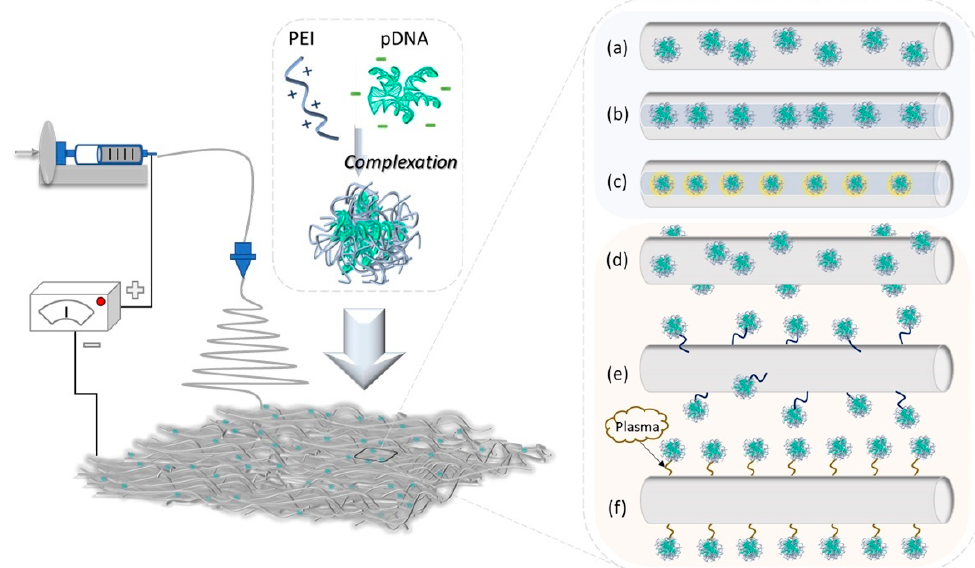
Figure 2. Fabrication strategies of electrospun fibrous architectures for controlled gene therapy drug delivery. The genetic material can be loaded within the electrospun fibrous architectures by encapsulation using: ( a ) blend electrospinning; ( b ) coaxial electrospinning; and ( c ) emulsion electrospinning, or it may be immobilized on the surface of preformulated electrospun fibrous architectures through: ( d ) physical adsorption; ( e ) covalent immobilization; and ( f ) plasma treatment.